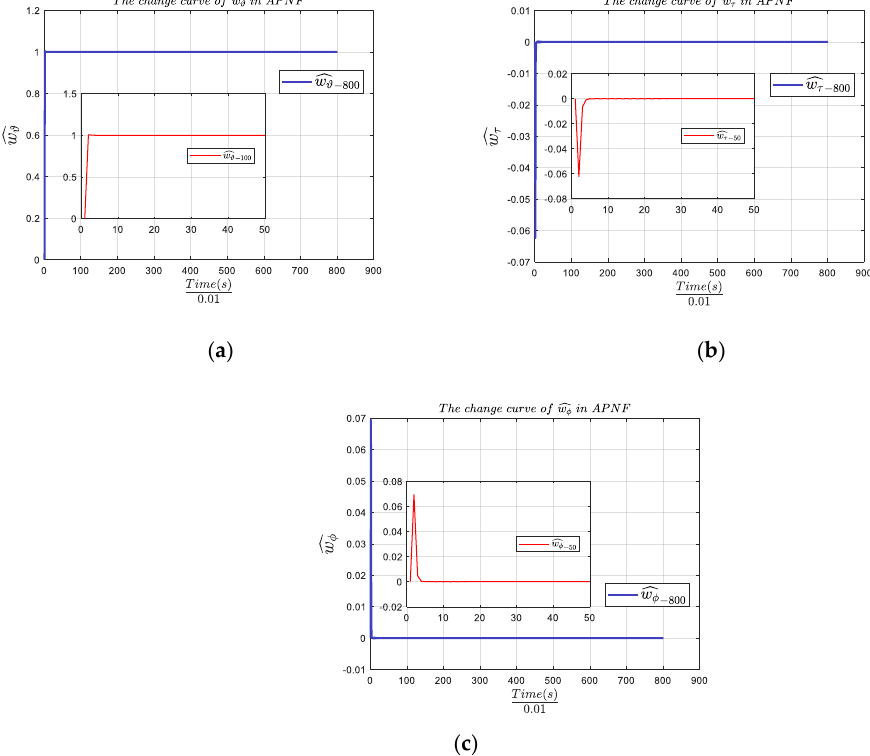
Figure 11. ( a ) Parameter change curve of 𝑤 𝜗 ̂ within 0.5 s and 8 s of APNF; ( b ) parameter change curve of 𝑤 𝜏 ̂ within 0.5 s and 8 s of APNF; ( c ) parameter change curve of 𝑤 𝜙 ̂ within 0.5 s and 8 s of APNF.